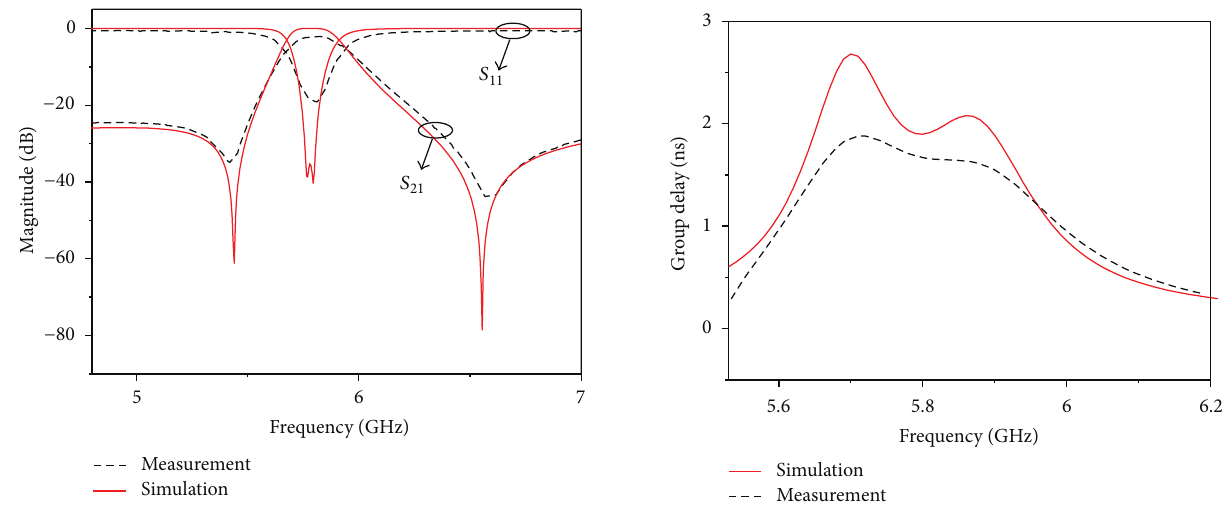
Figure 10: Measured and simulated frequency responses of the proposed dual-mode bandpass filter.